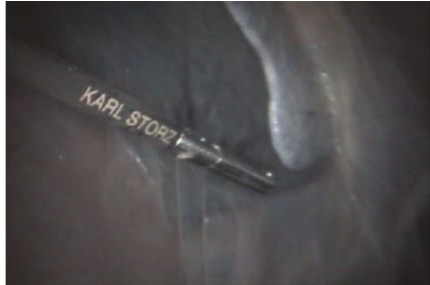
Figure 2: Laparoscopic examination of the caudal surface of the spleen and its attachment to the abdominal wall.